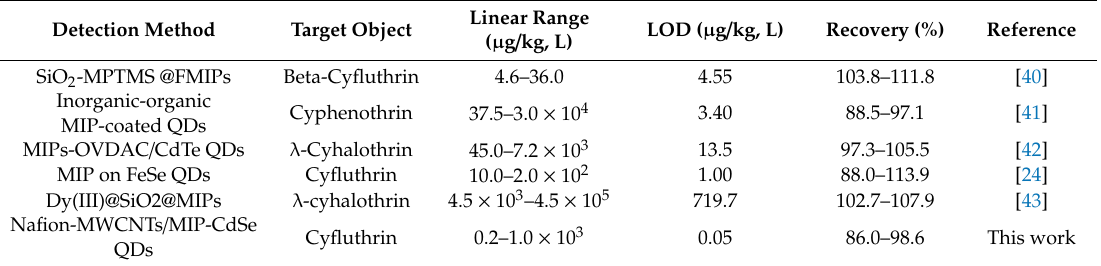
Table 2. Comparison of this method with other methods reported in the